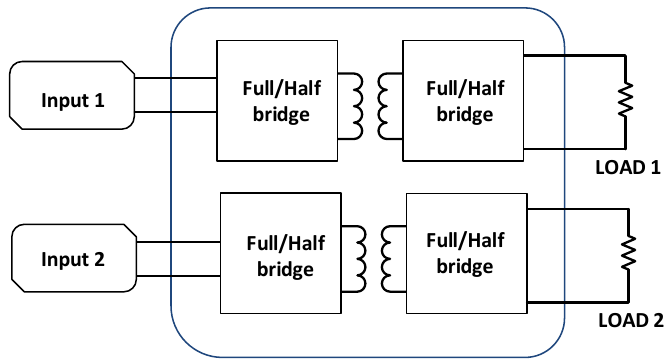
Figure 4. Structure of isolated double-input-double-output (DIDO) port converter system.